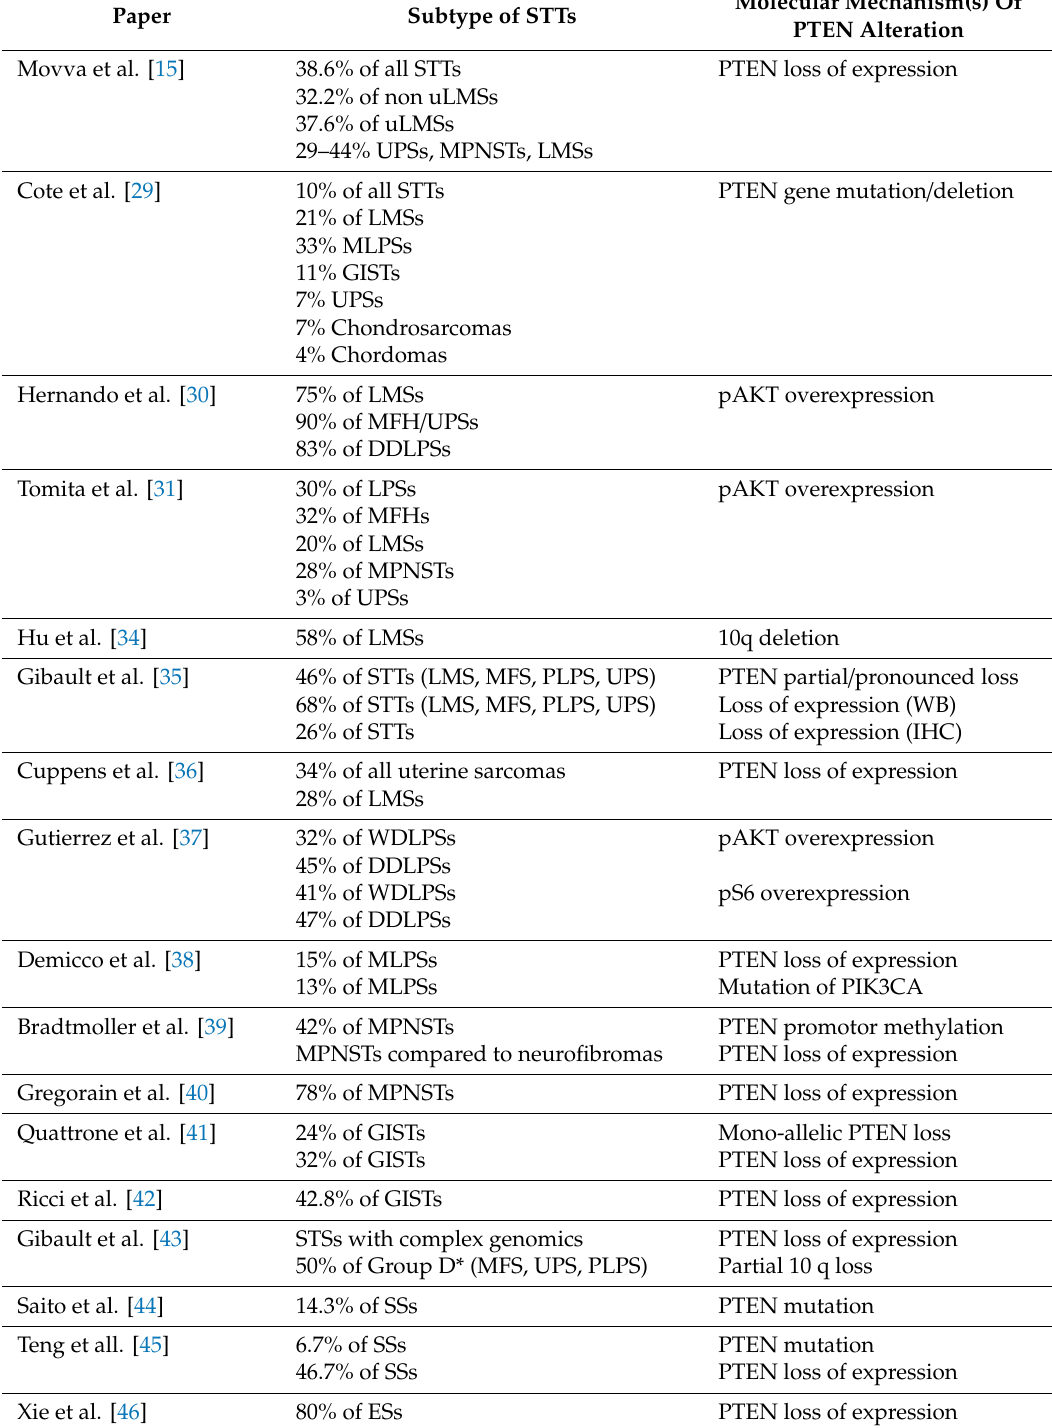
Table 1. Incidence of PTEN alterations in